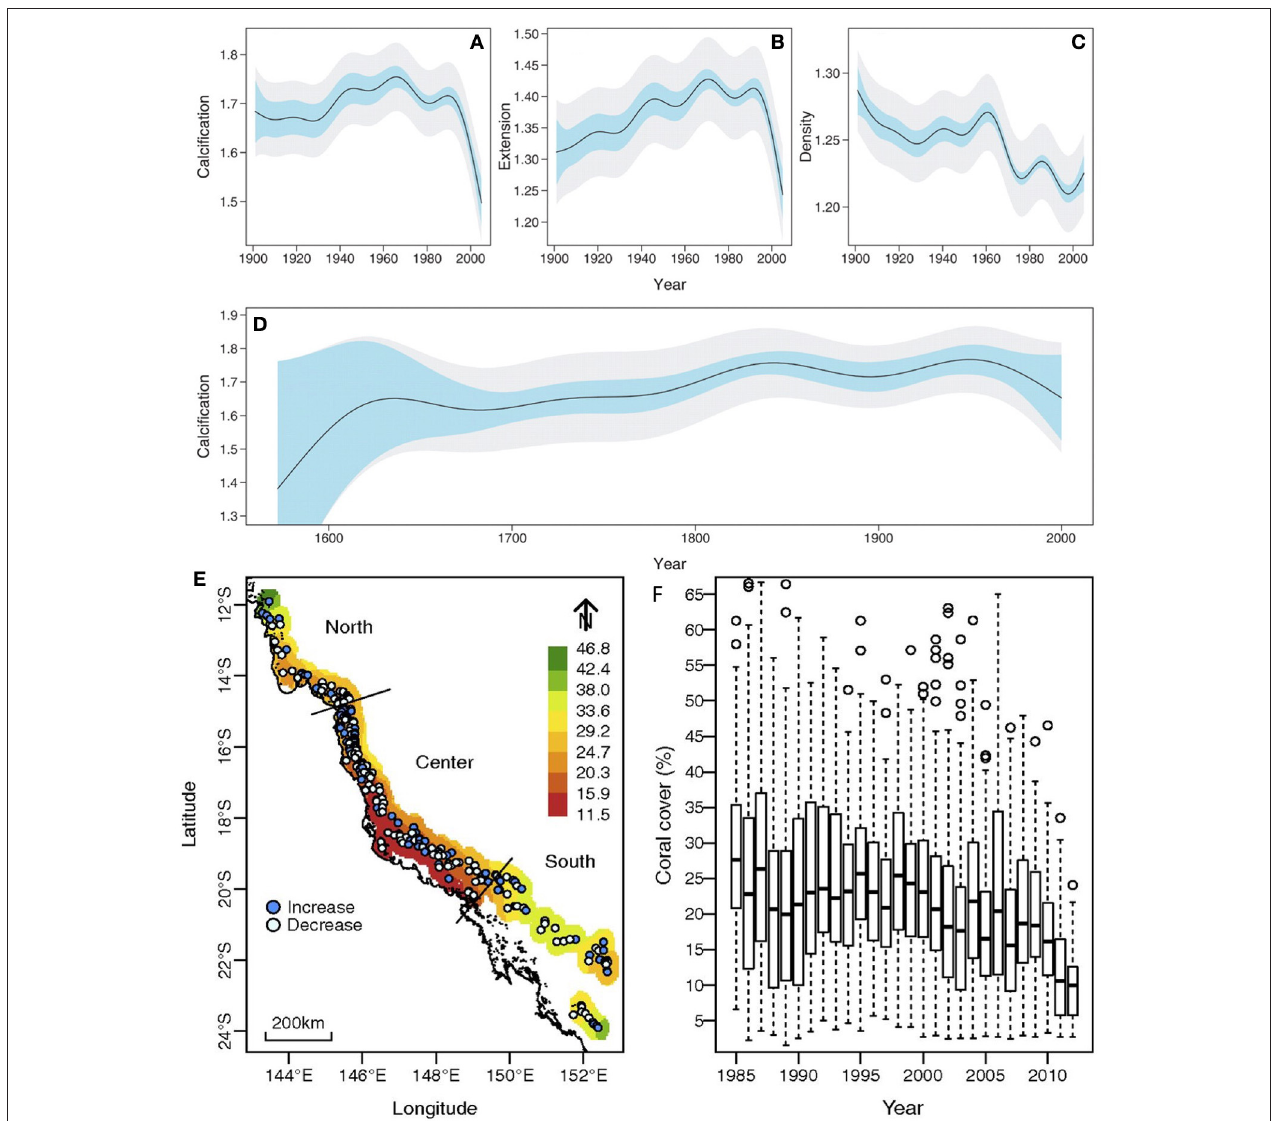
FIGURE 5 | (A–D) Partial-effects plots showing the variation of calcification (grams per square centimeter per year), linear extension (centimeters per year), and density (grams per cubic centimeter) in Porites from the Great Barrier Reef (GBR), Australia, over time. From De’ath et al. (2009). Plots (A–C) are based on 1900–2005 data from 328 Porites colonies, and plot (D) on data for ten long cores. Light blue bands indicate 95% confidence intervals for comparison between years, and gray bands indicate 95% confidence intervals for the predicted value for any given year. Calcification declines by 14.2% from 1990 to 2005 (A) , primarily due to declining extension (B) . Density declines from 1900 onward (C) . The 1572–2001 data show that calcification increased weakly from ∼ 1.62 before 1,700 to ∼ 1.76 in ∼ 1850, after which it remained relatively constant (D) before a weak decline since ∼ 1960. (D–F) Decline coral cover of the GBR over 1985–2012. (E) Map of GBR with color shading indicating mean coral cover averaged over 1985–2014. Points show the location of 214 survey reefs in the northern, central, and southern regions, and their color indicates the direction of change in cover over time. (F) Box plots indicate the percentiles (25, 50, and 70%) of the coral cover distributions within each year and suggest a substantial decline in coral cover over the 27 years. Adapted from De’ath et al. (2012) and with the permission according to PNAS